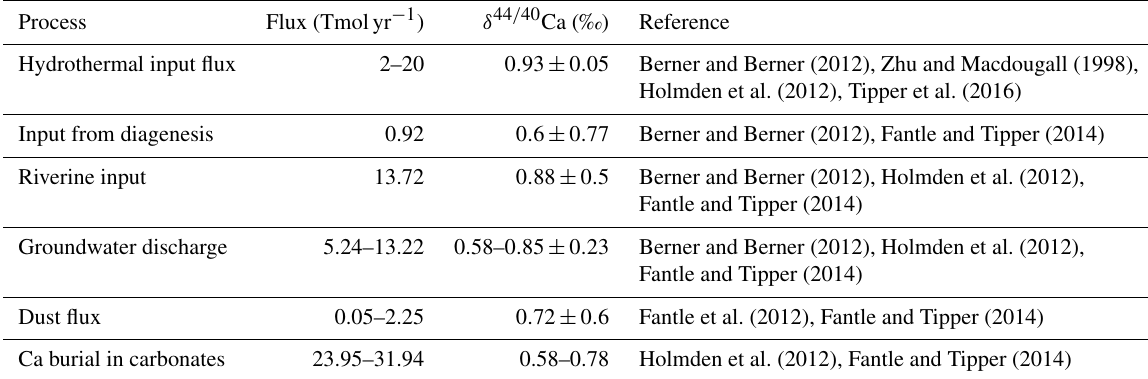
Table 4. Estimates of pre-industrial Ca fluxes between surface reservoirs and their isotopic composition. δ 44 / 40 Ca is given relative to